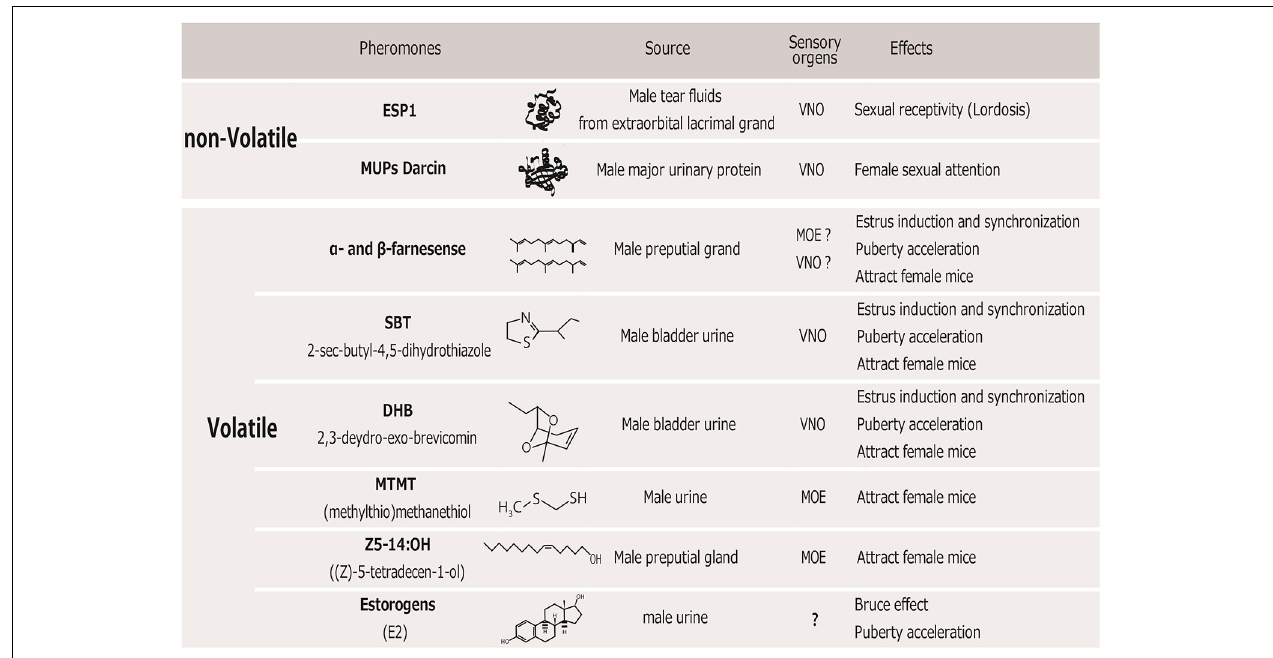
FIGURE 1 | Table of male pheromones that affect female mice. VNO, vomeronasal organ; MOE, main olfactory epithelium.